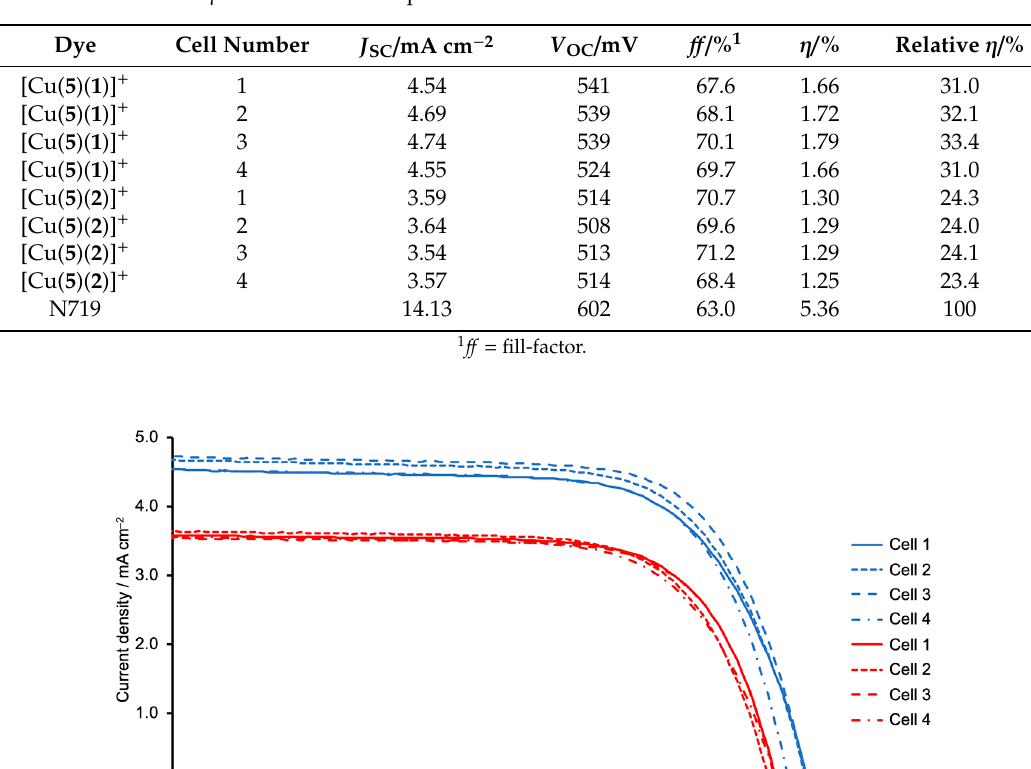
Table 1. Performance parameters (under 1 sun illumination) of duplicate, masked DSCs on the day of sealing the cells with the dyes [Cu( 5 )( 1 )] + and [Cu( 5 )( 2 )] + . The data are compared to a DSC containing N719 and relative η values are with respect to N719 set at 100%.